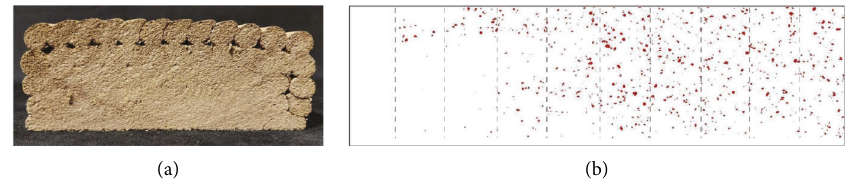
Figure 22: Printing component section (a) and the distribution of sawdust waste (b) [19].